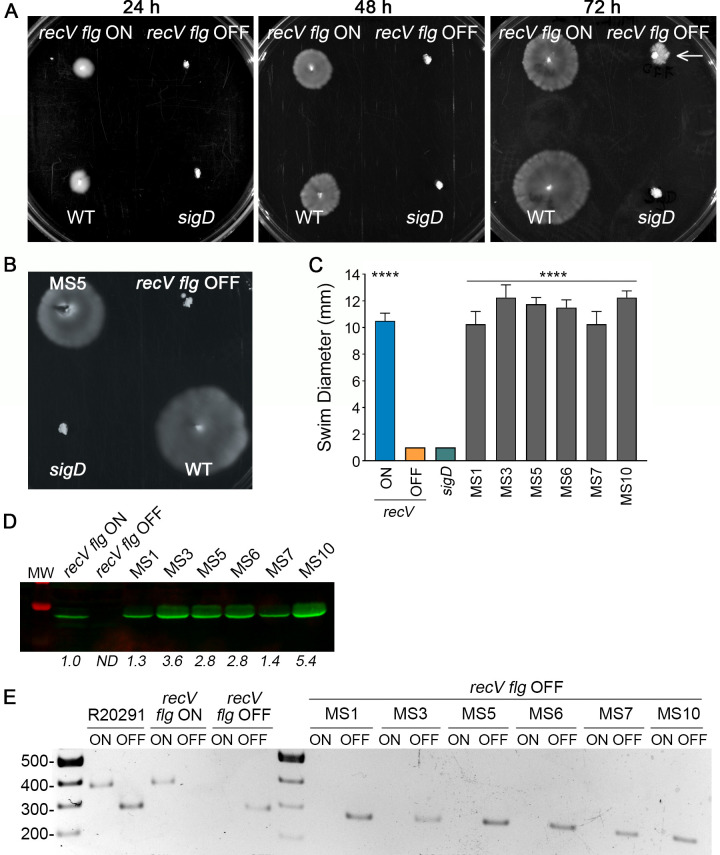
Motile suppressor mutants arise from a non-motile recV flg OFF strain.(A) Swimming motility in soft agar medium of C. difficile R20291 (WT), recV flg ON (RT1702), recV flg OFF (RT1693), and sigD-null non-motile control. Images were taken of representative plates after 24, 48 and 72 h. The arrow on the 72 h image points to a motile flare arising from recV flg OFF. (B) Swimming motility in soft agar medium of C. difficile R20291 (WT), recV flg OFF (RT1694), MS5, and sigD-null non-motile control. Image of a representative plate at 48 h. (C) Quantification of swimming motility of 6 motile suppressors (MS) selected for further characterization. Swim diameter was measured after 48 h. The means and standard deviation from 4 biological replicates are shown. ****p<0.0001 by one-way ANOVA and Dunnett’s post-test compared to recV flg OFF. (D) Immunoblot detection of FliC in recV flg ON and OFF and select MS. Shown is a representative image of three independent experiments. Numbers represent quantification of band intensity expressed as fold-change relative to recV flg ON. ND–non-detectable. (E) Orientation-specific PCR for flagellar switch in six motile suppressors, WT, and recV flg ON and OFF controls. Band sizes– 280bp (OFF) or 375bp (ON). Shown is a representative image of three independent experiments.